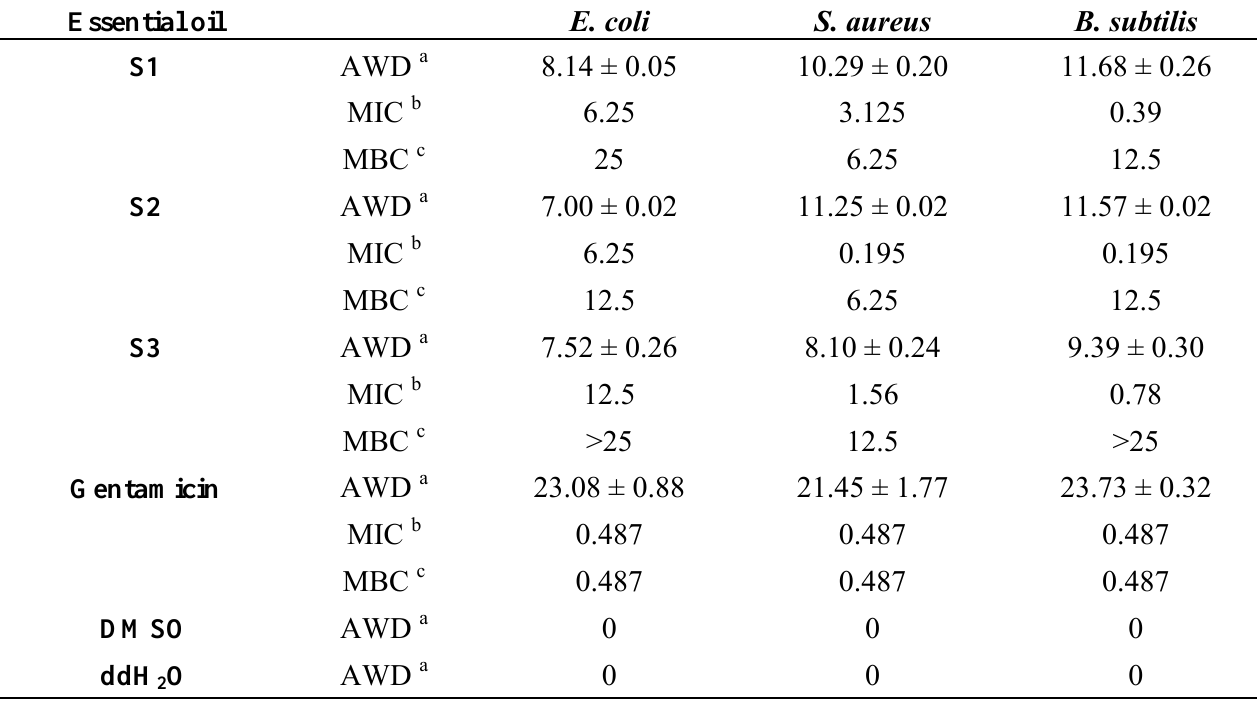
Table 2. Screening results for antimicrobial activity of the three essential